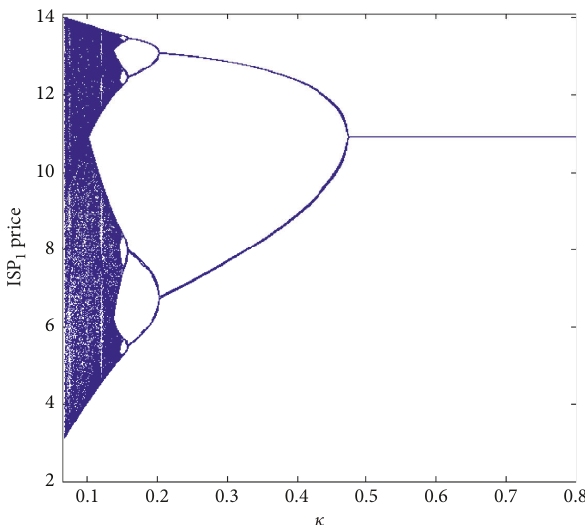
Figure 5: Bifurcation diagrams of p